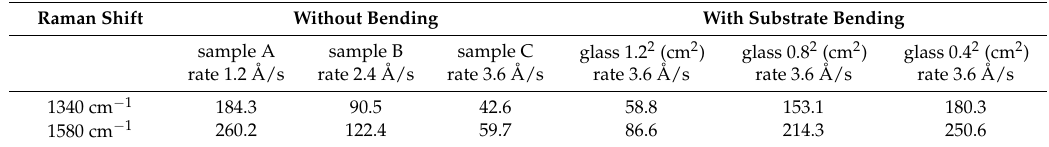
Figure 9. Schematic illustration of the boundary contour shapes of the islands developed by ( a ) typical thermal evaporation, ( b ) thermal evaporation with substrate bending. ( c , d ) are SEM images of 65 ◦ cross section of sample A and sample D with 4 × 10 5 magnification, respectively. Table 3. The average Raman intensities at the 1340 and 1580 cm − 1 features of samples prepared with various